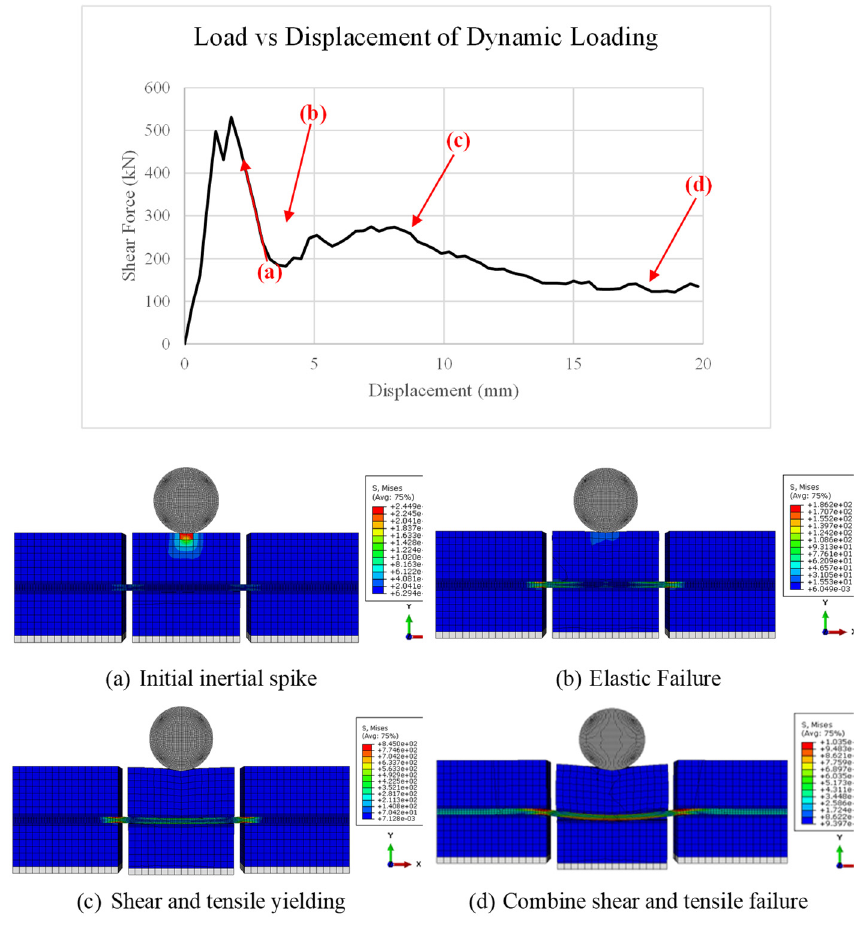
Figure 25. Failure of dynamically loaded bolt.